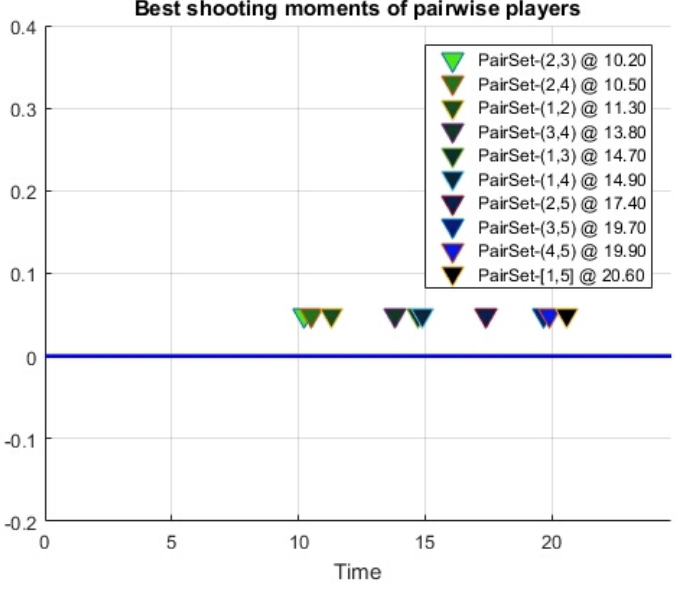
Figure 3. The shooting order of a five-person duel